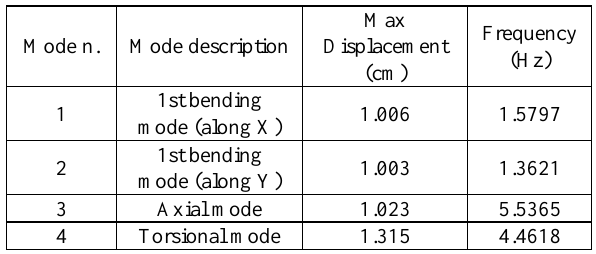
Table 1. Natural frequencies analysis of the main mode shapes of the bell tower